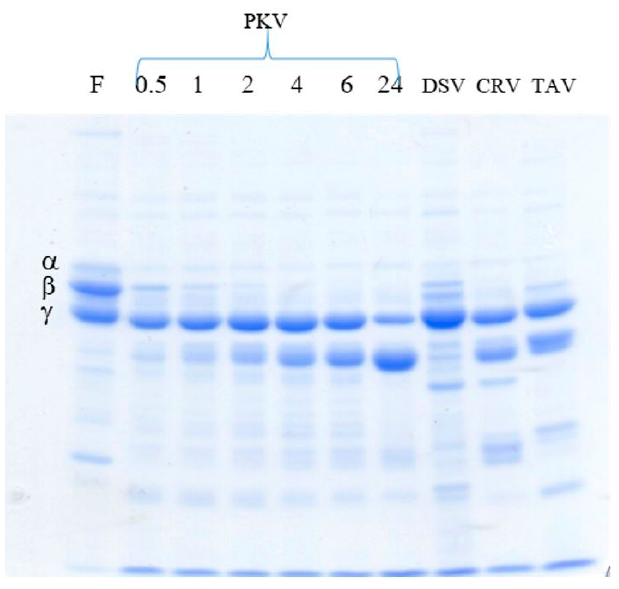
Figure 1. Fibrinogenolytic activity of Protobothrops kelomohy venom (PKV). PKV was incubated with fibrinogen (F) at various times (0, 0.5, 1, 2, 4, 6 and 24 h) in comparison with the other venoms incubated with fibrinogen at 24 h only. The bands corresponding to α, β and chains of fibrinogen (F) are labelled. DSV: Daboia siamensis venom ; CRV: Calloselasma rhodostoma venom ; ɣ TAV: Trimeresurus albolabris